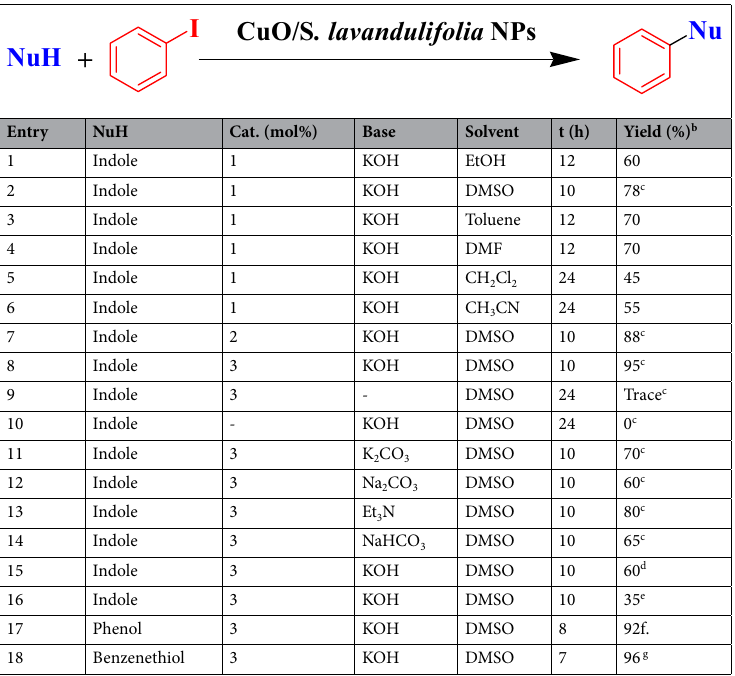
erto known, this is the first report representative of biosynthesized CuO/ Stachys lavandulifolia NP catalyzed C–heteroatom coupling reaction. The green protocol draws attention in terms of its simple, handy and cost- effective biogenesis of nanocatalyst, convenient operations, recyclability of catalyst and exceptional productivity.